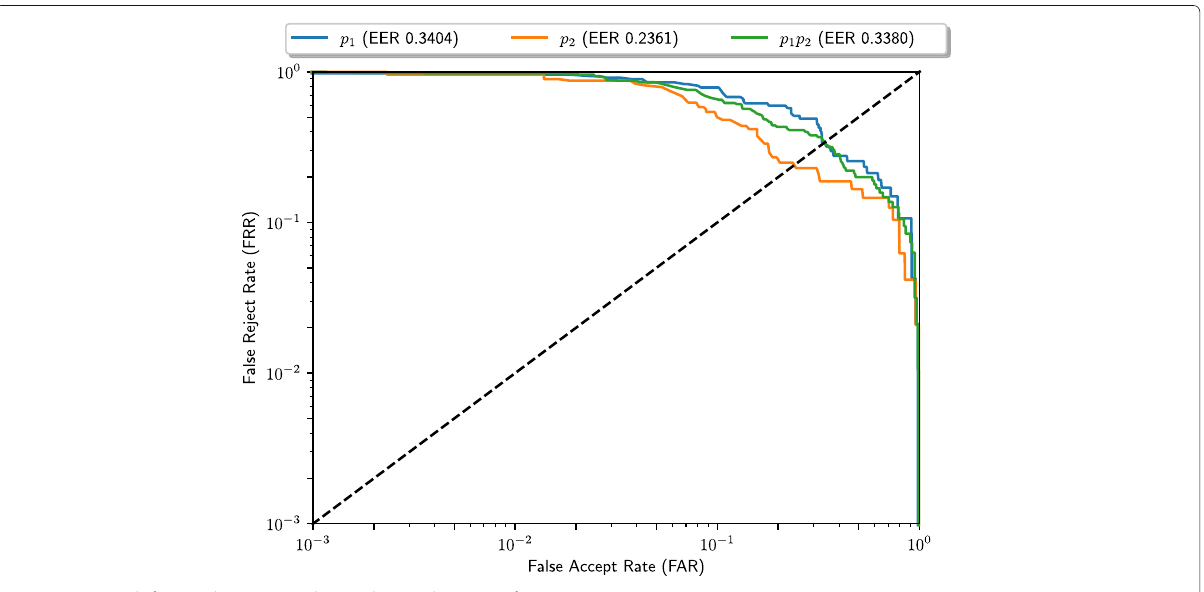
Fig. 6 DET graph for T 3.1 (lower EER values indicate a better performance)